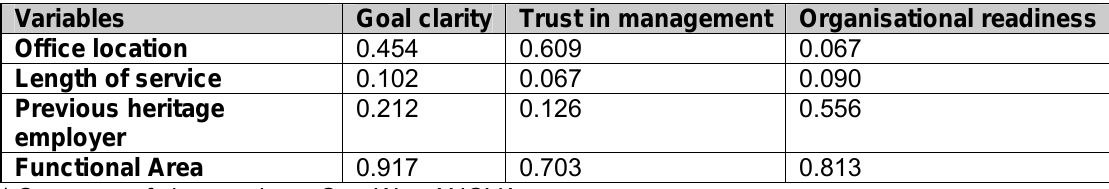
Table 2: The relationship between main variables and demographic variables*